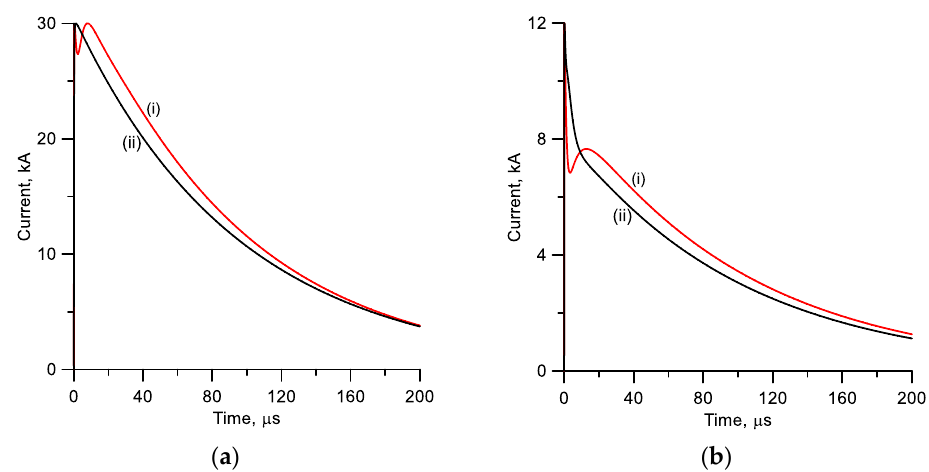
Figure 14. Alternative current waveforms (curves marked (i)) ( a ) for first return strokes and ( b ) for subsequent return strokes that could be used with the MTLD model without current dispersion to generate electromagnetic fields similar to those observed in practice. The curves marked (ii) are the standard current waveforms used in the calculations.